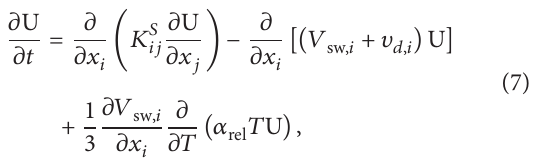
and as a function of the solar distance inside the colatitude regions Pol Par as a function of colatitude: values in 𝐁𝐁 𝐁𝐁 of colatitude lead to same results of those 𝛿𝛿 𝑚𝑚 ∘ 90